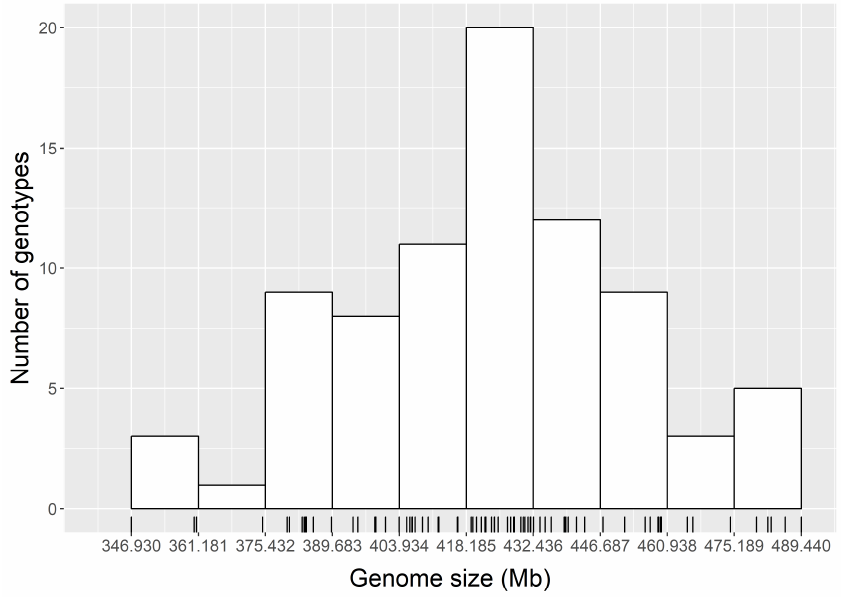
Figure 9. Histogram distribution of genome sizes of 81 genotypes of sour jujube.